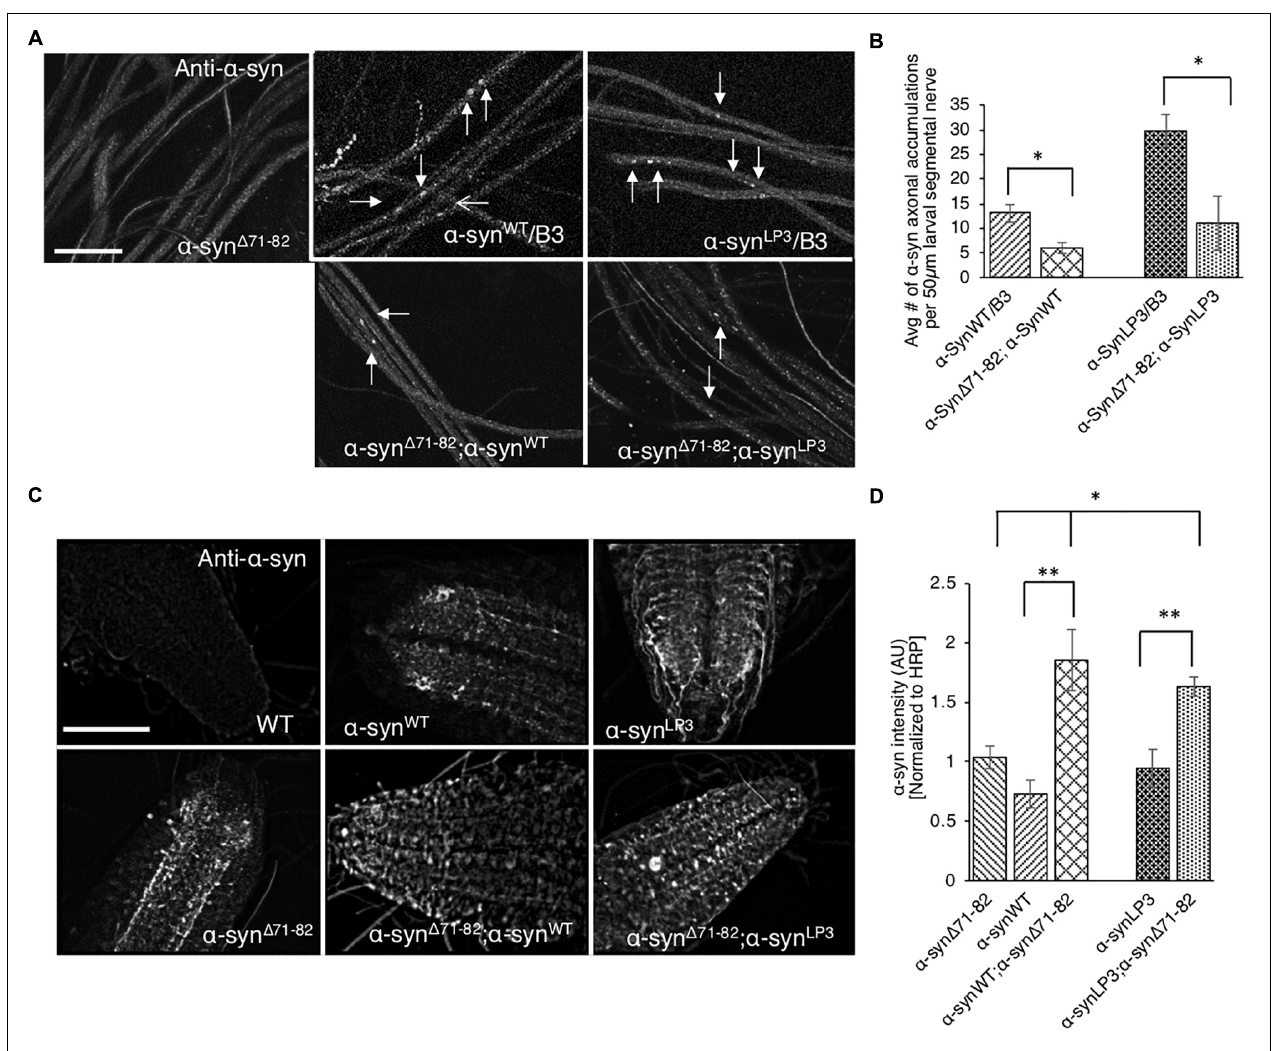
FIGURE 7 | Expression of α -syn lacking the NAC region suppresses α -syn accumulations within larval nerves and increases α -syn in larval brains. (A) Larval segmental nerves expressing α -syn (cid:49) 71 − 82 with α -syn WT or α -syn LP3 stained with the α -syn antibody. The α -syn WT /B3 and α -syn LP3 /B3 segmental nerves are siblings from each genetic cross and show α -syn accumulations (arrows). Note that the amounts of α -syn accumulations in larval segmental nerves from larvae co-expressing α -syn (cid:49) 71 − 82 ; α -syn WT or α -syn LP3 ; α -syn (cid:49) 71 − 82 are reduced compared to sibling larvae expressing α -syn WT or α -syn LP3 alone (arrows, bar = 10 µ m). (B) Quantitative analysis indicates significant decreases in α -syn accumulations in larval segmental nerves co-expressing α -syn (cid:49) 71 − 82 ; α -syn WT or α -syn LP3 ; α -syn (cid:49) 71 − 82 compared to larvae expressing α -syn WT /B3 or α -syn LP3 /B3 ( p < 0.05, n = 6). The quantitative analysis represents mean ± SEM. ∗ p < 0.05. (C) α -Syn staining in larval brains from α -syn (cid:49) 71 − 82 ; α -syn WT or α -syn (cid:49) 71 − 82 ; α -syn LP3 compared to α -syn WT , α -syn LP3 or α -syn (cid:49) 71 − 82 alone. (D) Quantification of α -syn intensity (normalized to HRP) within larval brains from co-expressing α -syn (cid:49) 71 − 82 ; α -syn WT or α -syn (cid:49) 71 − 82 ; α -syn LP3 compared to larvae expressing α -syn WT , α -syn LP3 , or α -syn (cid:49) 71 − 82 alone indicates a significant increase in α -syn ( ∗ p < 0.05, ∗∗ p < 0.01, n = 5). The quantitative analysis represents the mean ± SEM. AU = arbitrary